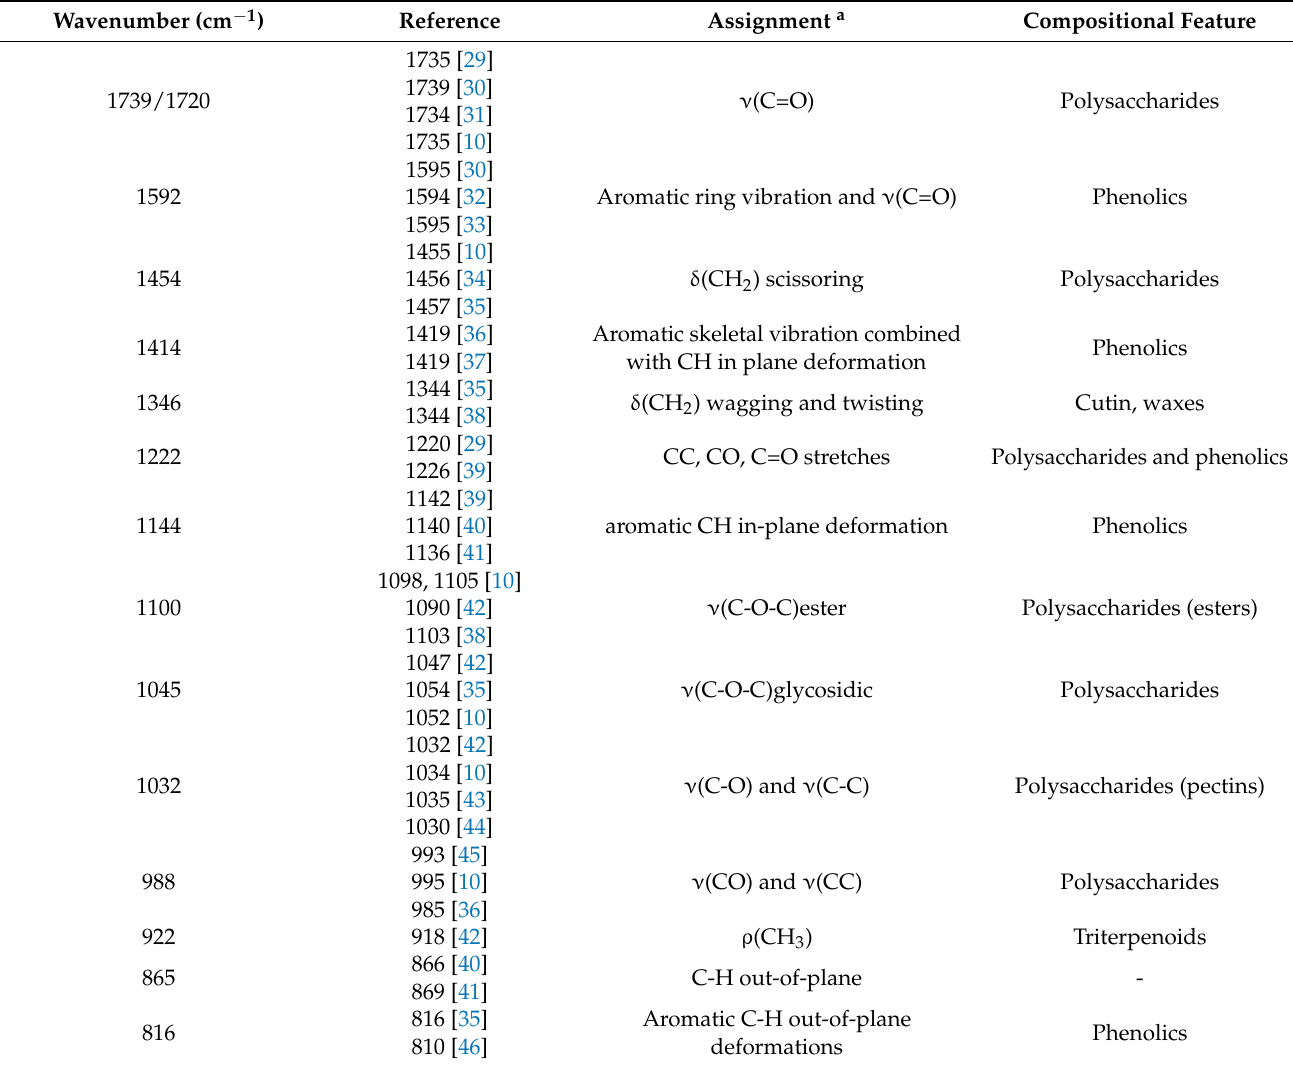
Table 5. FTIR-ATR wavenumbers (cm − 1 ) and tentative assignments for the tamarillo extracts un- der